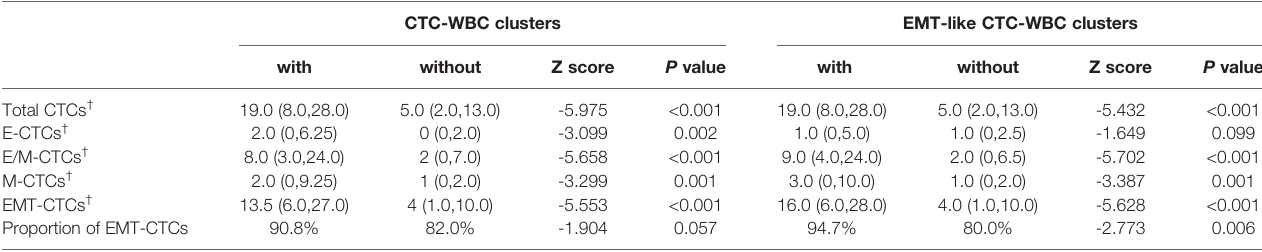
TABLE 1 | The correlation between different subtypes of CTCs and the presence of CTC-WBC clusters as well as EMT-like CTC-WBC clusters. CTC-WBC clusters EMT-like CTC-WBC clusters with without